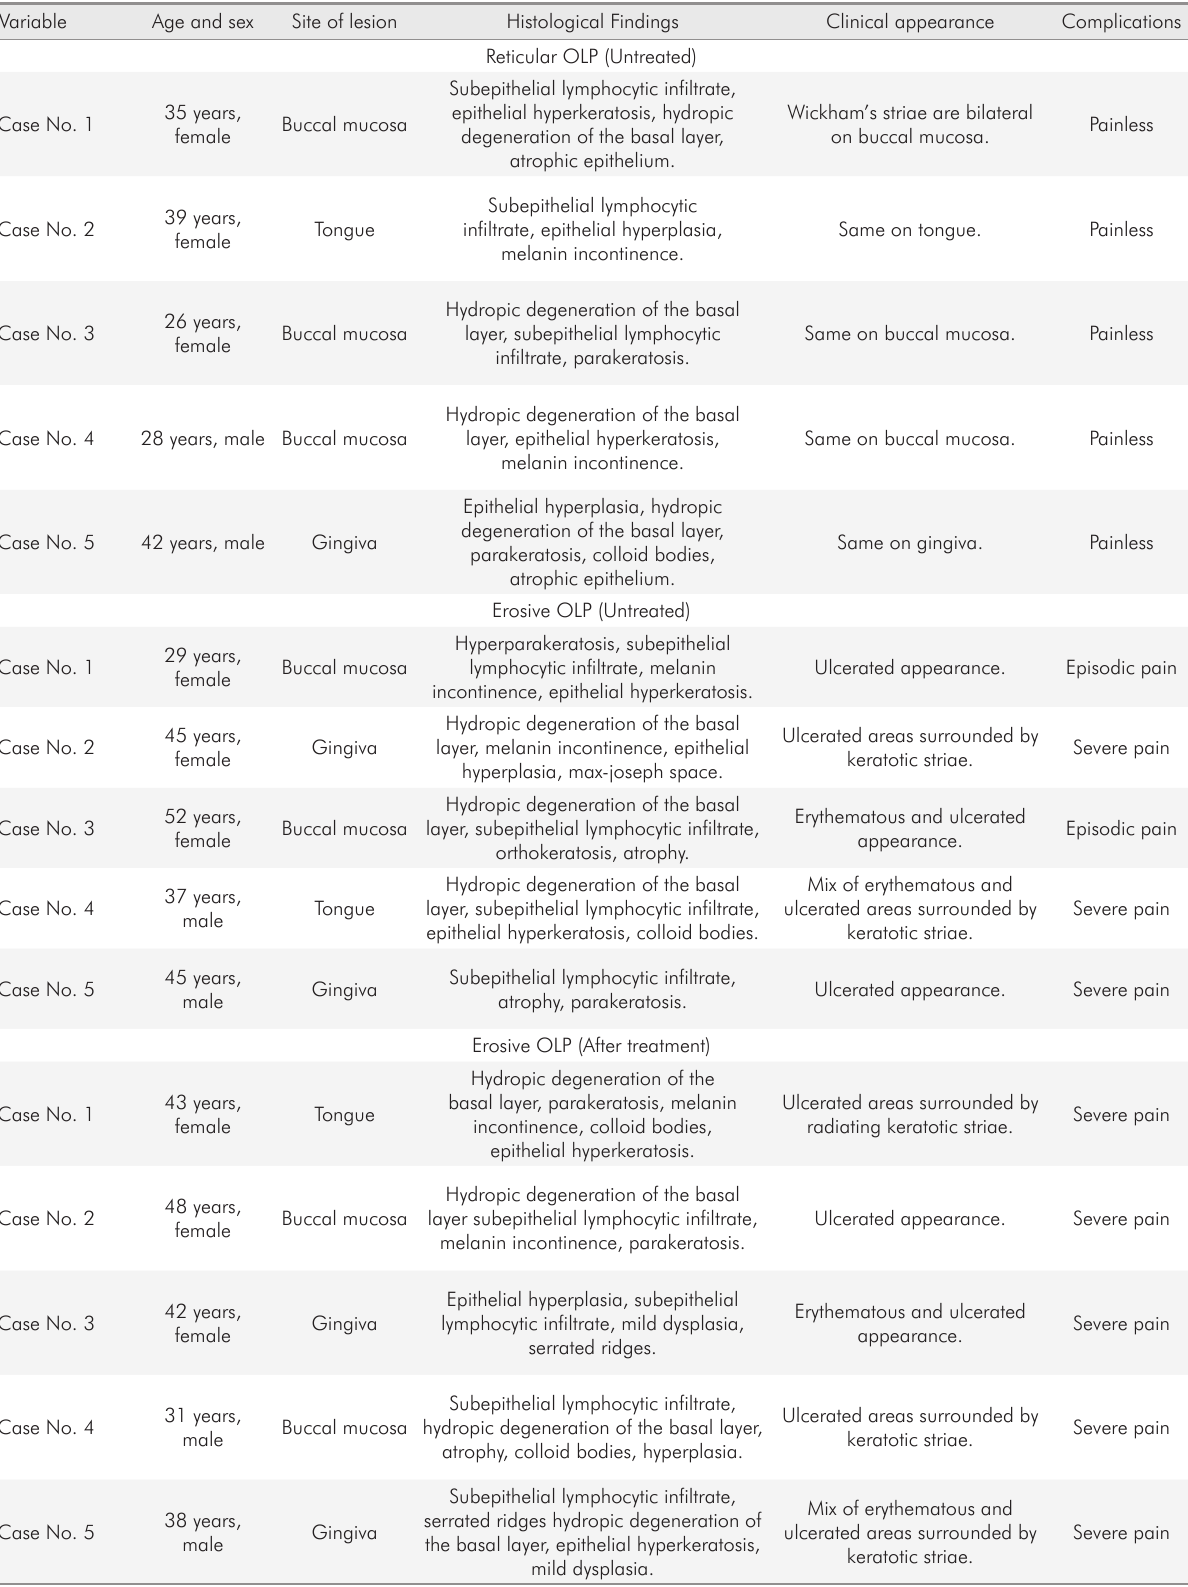
Table 1. Oral lichen planus (OLP) patients enrolled for molecular biology analysis (patient reports).